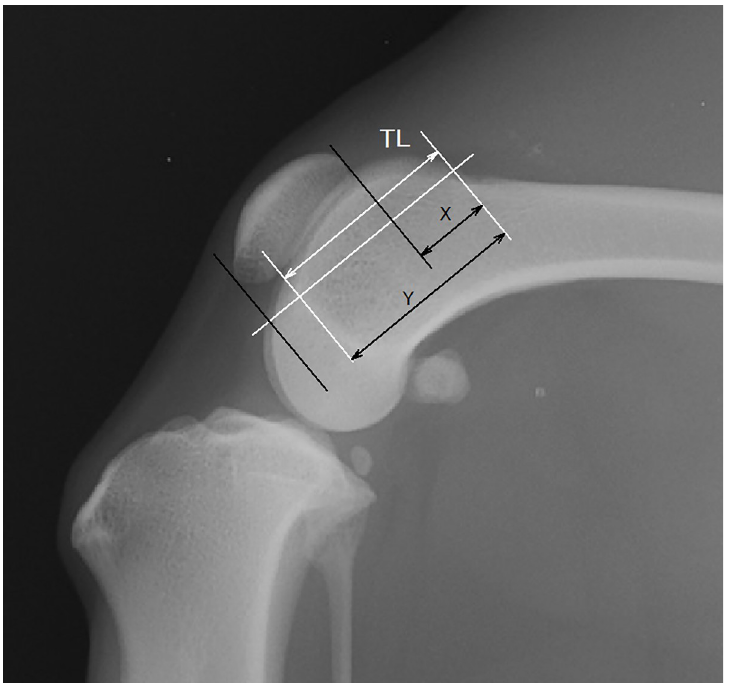
Fig 3. The measurement definitions of the femoral trochlear length (TL), proximal patellar position (PPP), and distal patellar position (DPP). The TL was measured from the proximal extent of the femoral trochlear ridges to the origin of the long digital extensor muscle. X is the distance from the proximal end of the TL to the proximal edge of the patella. The PPP was defined as X/TL. Y is the distance from the proximal end of the TL to the distal edge of the patella. The DPP was defined as